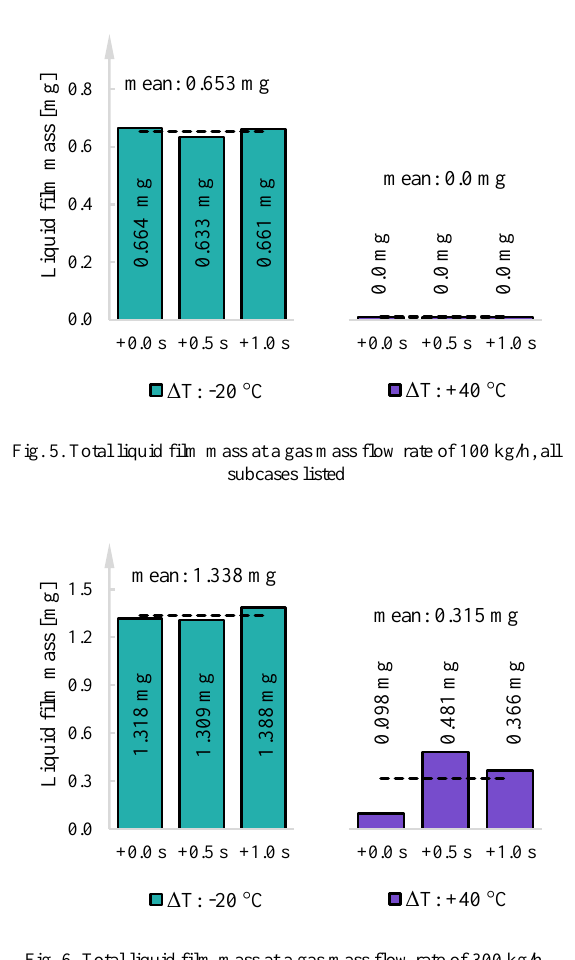
Fig. 6. Total liquid film mass at a gas mass flow rate of 300 kg/h, all subcases listed The resulting values indicated a relatively low liquid film mass inside the system. An increased gas mass flow rate led to a rise in film mass, which resulted from in- creased injection time and hence a longer time when the droplet-wall collisions occurred. The liquid film was ob- served mostly on the plate due to intense local cooling caused by liquid impingement. It particularly concerned the subcooled injection characterised by a narrower spray plume and higher impingement velocity. The constriction above the mixing chamber caused intensified droplet-wall Fig. 4. Turbulence kinetic energy, mass flow rate: 300 kg/h; a. prevailing contacts. However, no film was formed there because of the layout, b. flow breakdown, c. flow recovery high droplet dispersion and low degree of local cooling. Trace amounts of the film were deposited in the mixing Since the flow field was subjected to fluctuations, each chamber and near the injector. The latter resulted of the cases was evaluated thrice. Namely, with different